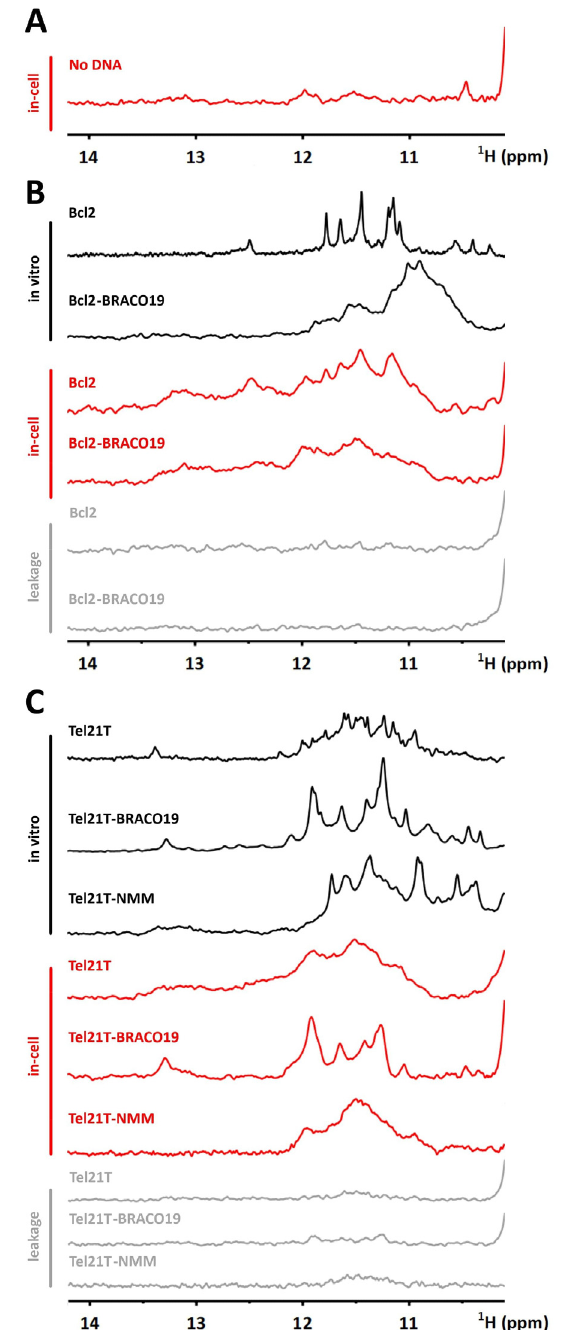
Figure 3. ( A ) Imino region of 1D 1 H NMR spectra of “empty” RPE cells. ( B ) Imino regions of 1D 1 H NMR spectra of Bcl2 and Bcl2–BRACO19 complex acquired in EC buffer (black line) and cells (red line). ( C ) Imino regions of 1D 1 H NMR spectra of Tel21T, Tel21T–BRACO19, and Tel21T–NMM complex acquired in EC buffer (black line) and cells (red line). NMR spectra presented in gray in ( B , C ) correspond to the respective in-cell NMR leakage controls.